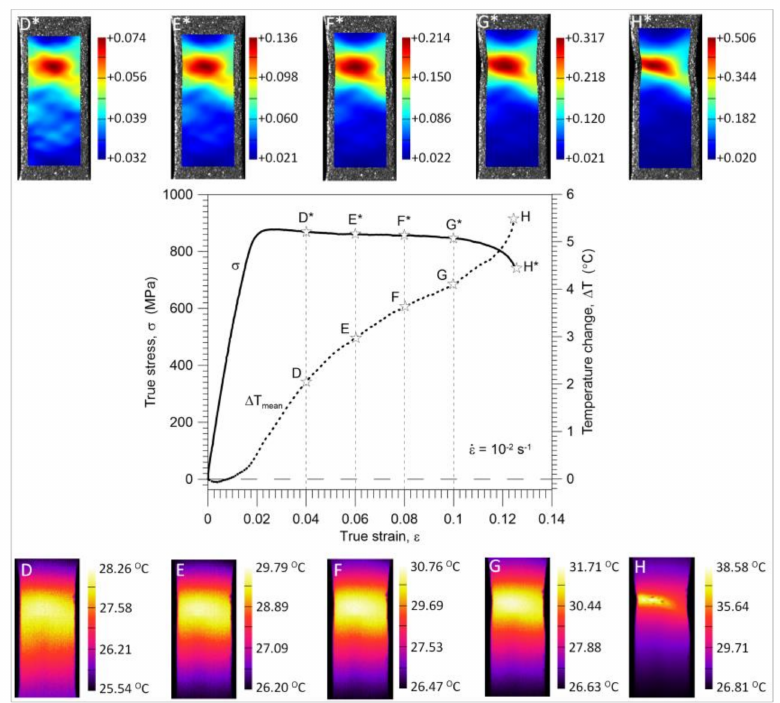
Figure 8. Stress σ and temperature change ∆ T mean versus strain ε completed by related DIC strain (above) and IR temperature (below) distributions for Gum Metal in tension at a strain rate of 10 − 2 s − 1 .